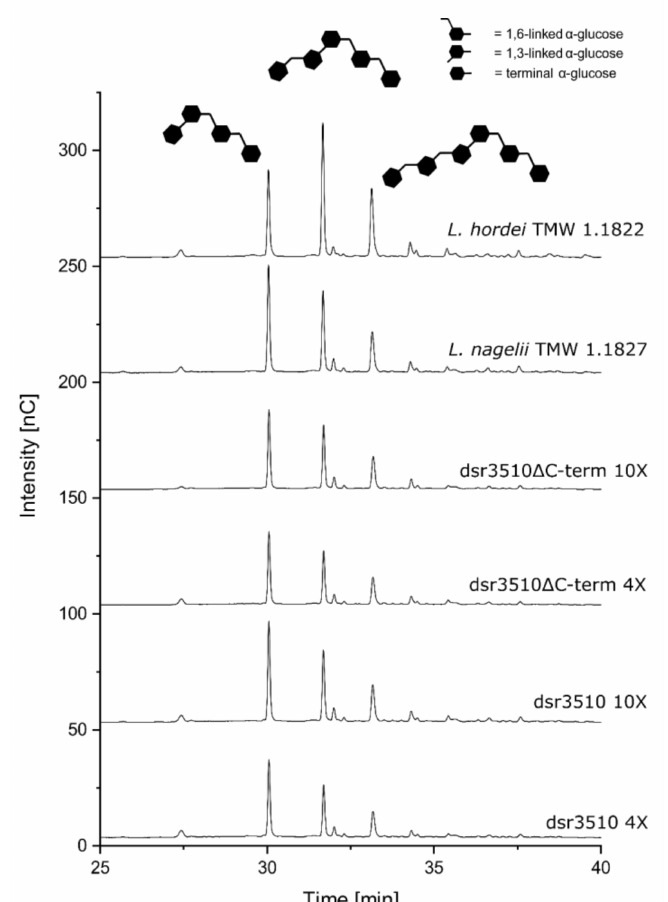
Figure 4. Endo-dextranase fingerprints of dextrans produced over 24 h at 30 ◦ C by heterologously expressed dextransucrases dsr3510 and dsr3510 ∆ C-term that were applied at a 4-fold and 10-fold dilution of the enzyme extracts, respectively. For comparison, the dextrans produced by native extracellular dextransucrases of L. hordei TMW 1.1822 and L. nagelii TMW 1.1827 under equal